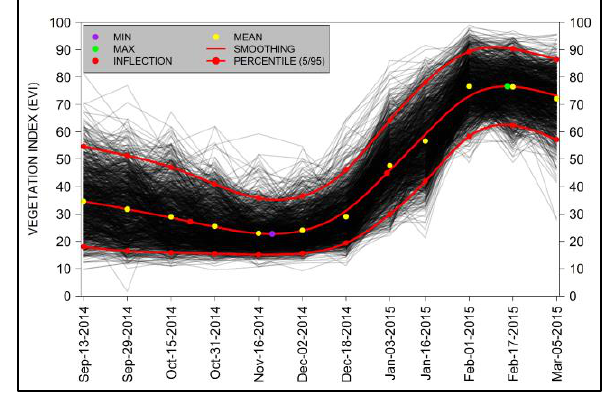
Figure 9. Chart of cluster 1.